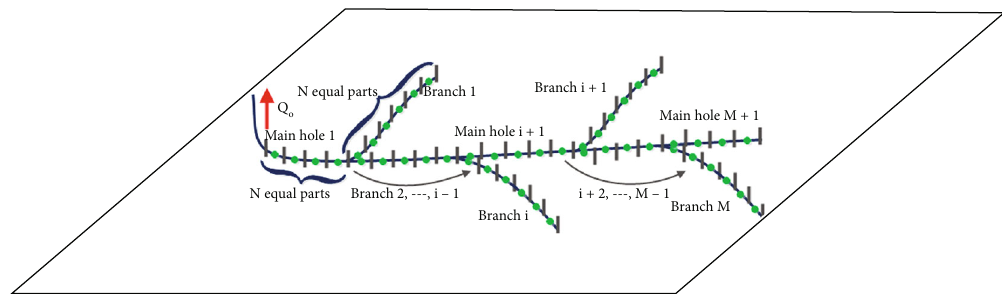
Figure 4: Microelement division of fi shbone